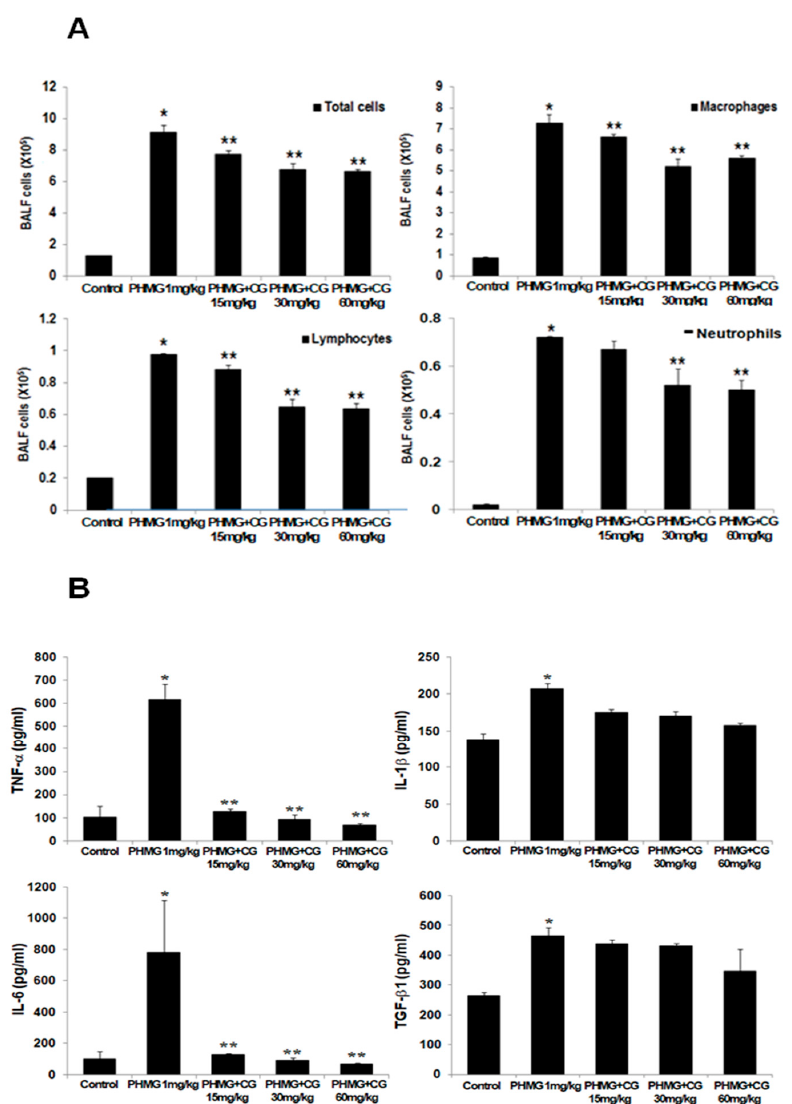
Figure 5. CG-745 ameliorates pulmonary inflammation induced by PHMG in mice. ( A ) The number of total cells, macrophages, neutrophils, and lymphocytes in the bronchoalveolar lavage fluid (BALF) was counted. ( B ) The levels of TNF- α , IL-1 β , IL-6 and TGF- β 1 in the BALF were analyzed by ELISA. Data are presented as mean ± SD, n = 5. * p < 0.01 versus control group. ** p < 0.05 versus PHMG